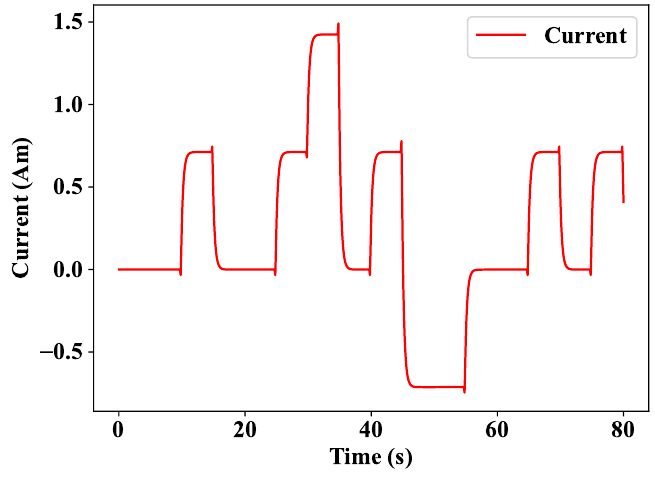
Figure 12. Measured current control response.